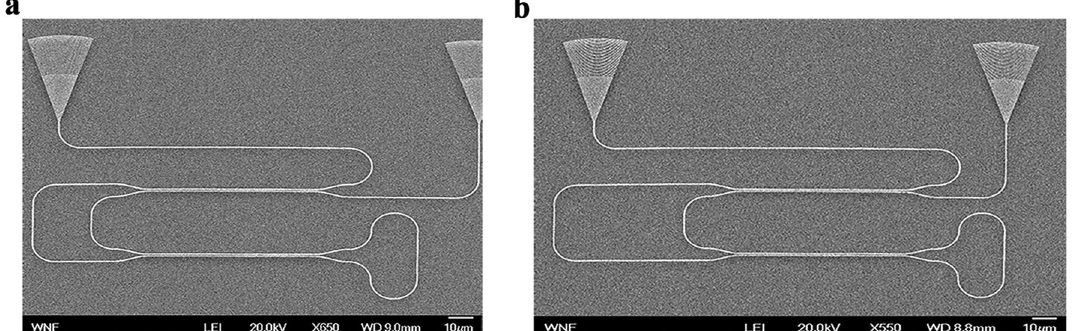
Figure 3. SEM photos of the fabricated LT-aMZIs: ( a ) with ΔL = 44.7 µm, ( b ) with ΔL = 89.4